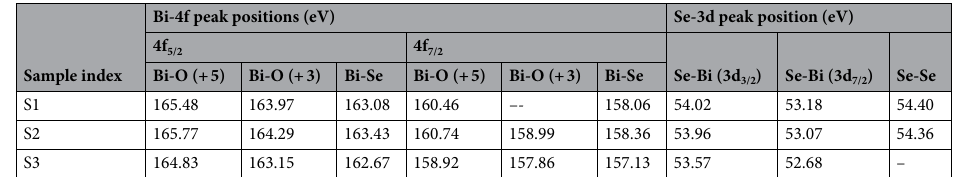
Table 2. Fitted XPS peak positions of Bi-4f core level spectra Se-3d core level spectra for samples S1–S3.